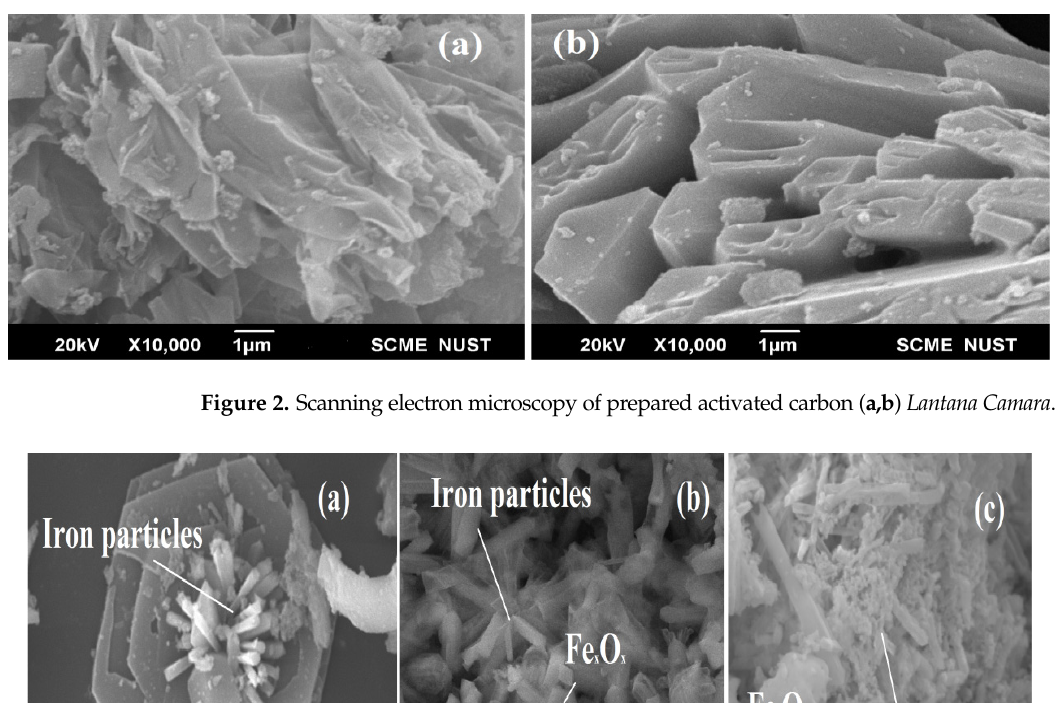
Figure 2. Scanning electron microscopy of prepared activated carbon ( a ) Lantana Camara ( b ). Lan- tana Camara